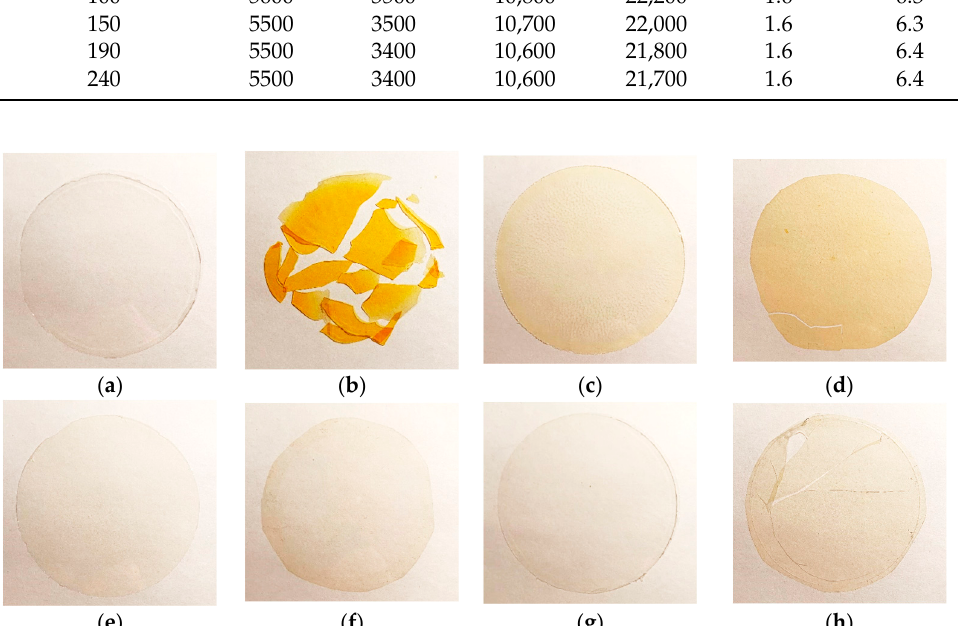
Figure 3. Visual appearance of pure and stabilized PTMSP films before and after heat treatment (140 °C): pure PTMSP-3 before ( a ) and upon 24 h of heat treatment ( b ); PTMSP-1 with Irganox 1010 before ( c ) and upon 72 h of heat treatment ( d ); PTMSP-3 with Irganox 1010 before ( e ) and upon 240 h of heat treatment ( f ); PTMSP-3 with Vulkanox BHT before ( g ) and upon 150 h of heat treatment ( h ). The data show that in a series of polymers containing from 50 to 80% cis -units, PTMSP- 1 with a mixed microstructure had the lowest thermal-oxidative stability. The